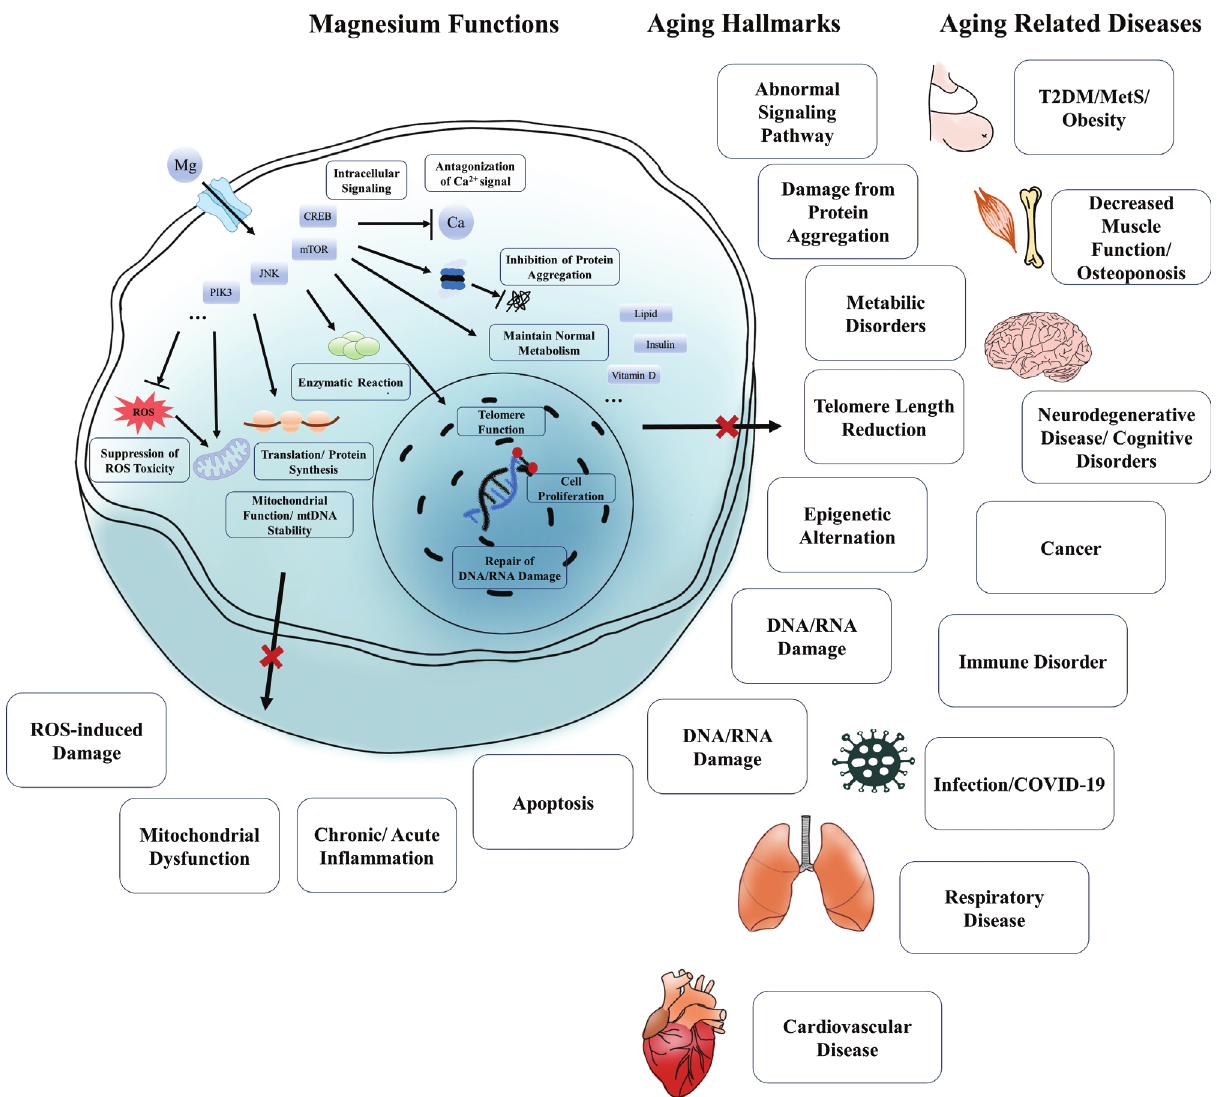
Fig. 2. The role of Mg 2+ in cell physiology, aging, and aging-related disease. Mg 2+ contributes to the regulation of intracellular environment, signaling pathways, cation concentration, and mitochondrial function. Mg 2+ is critically linked to molecular hall- marks of aging and is involved in the development of aging-related